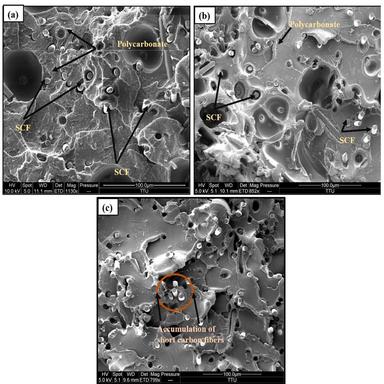
SEM images showing fiber distribution (by vol.) for (a) 3 % (b) 5 % (c) 10 %.